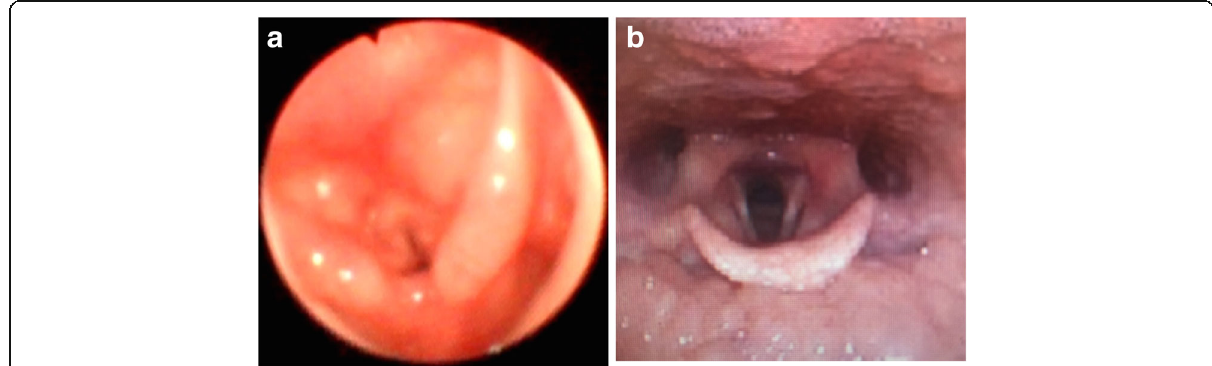
Fig. 1 The larynx of the patient with Kniest dysplasia was endoscopically evaluated immediately after two trials of tracheal intubation a in the operating room and b in the outpatient room 1 month